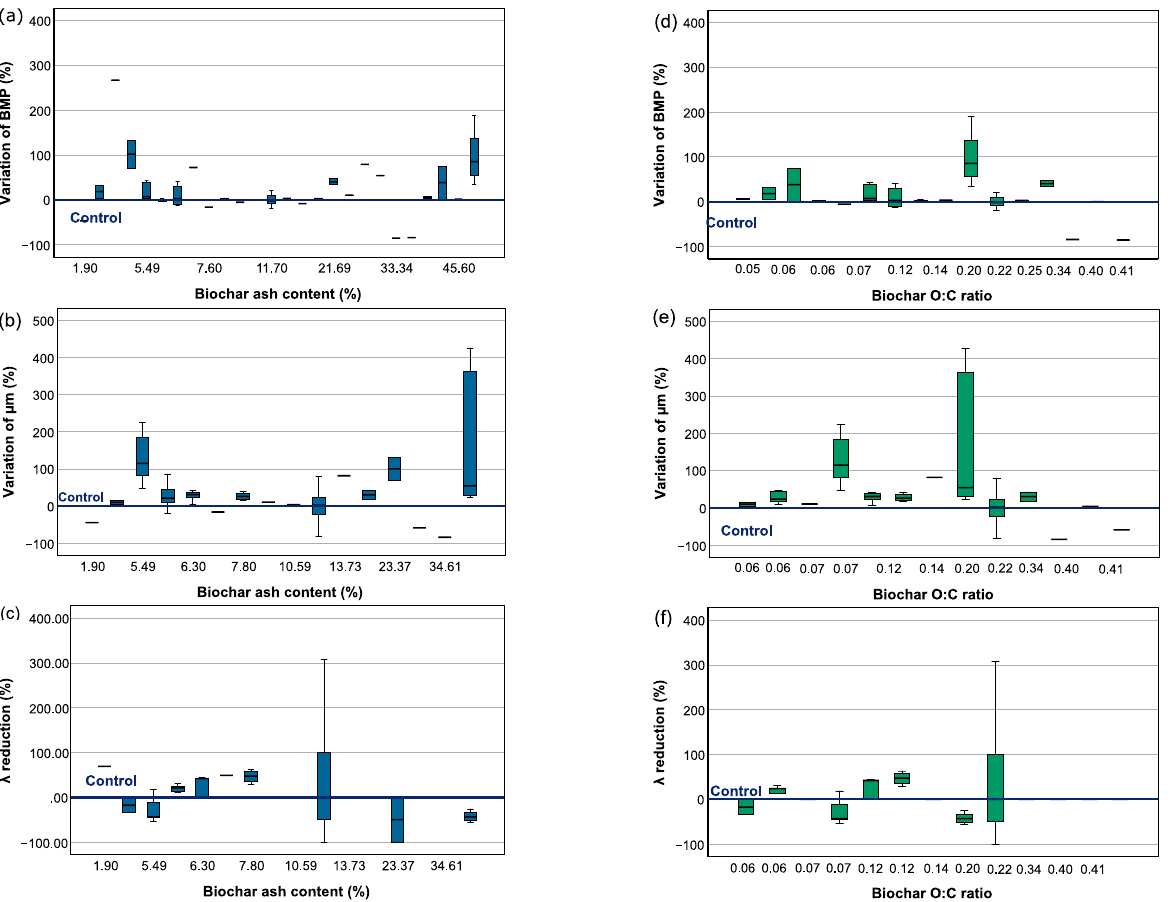
Figure 4. Box plot for the distribution of the relation between the variables for the composition of the biochars and their effect in anaerobic digestion parameters: effect of BC ash content on BMP ( a ), µ m ( b ) and λ reduction ( c ); effect of BC O:C ratio on BMP ( d ), µ m ( e ), and λ reduction ( f ).